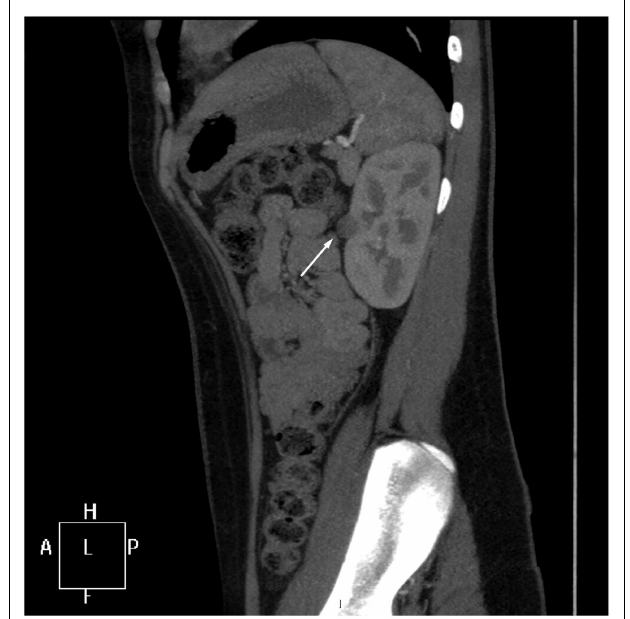
FIGURE 1 | CT angiogram . A sagittal reformat through the left kidney shows a rounded 10mm low-attenuation lesion projecting from the extreme periphery of the anterior renal margin, appearing subcapsular in position (arrow).